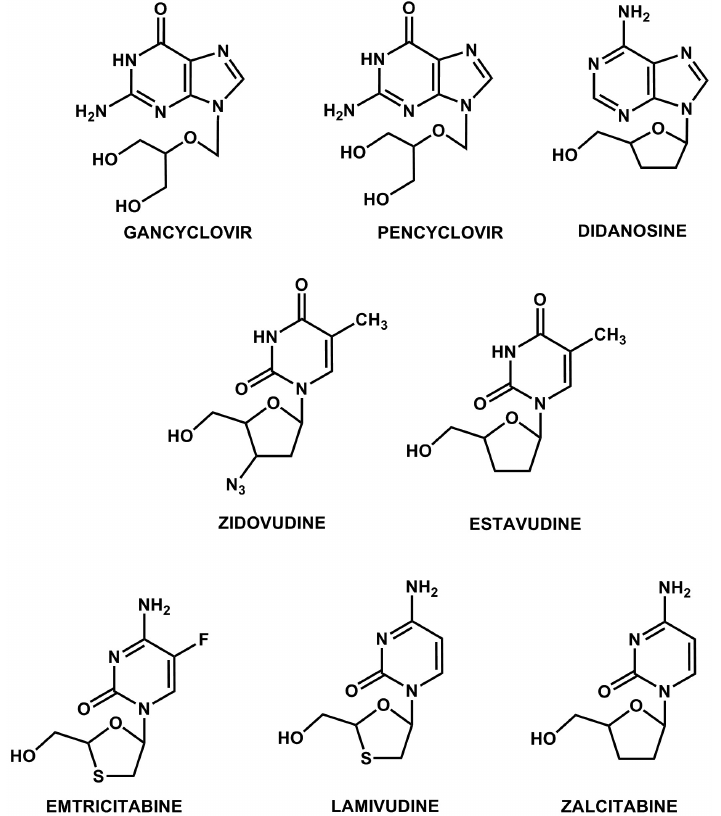
FIGURE 6 - Structures of bioprecursor-type antiviral prodrugs (ganciclovir and penciclovir) and antiretrovirals (zidovudine, estavudine, didanosine, emtricitabine, lamivudine, zalcitibine).